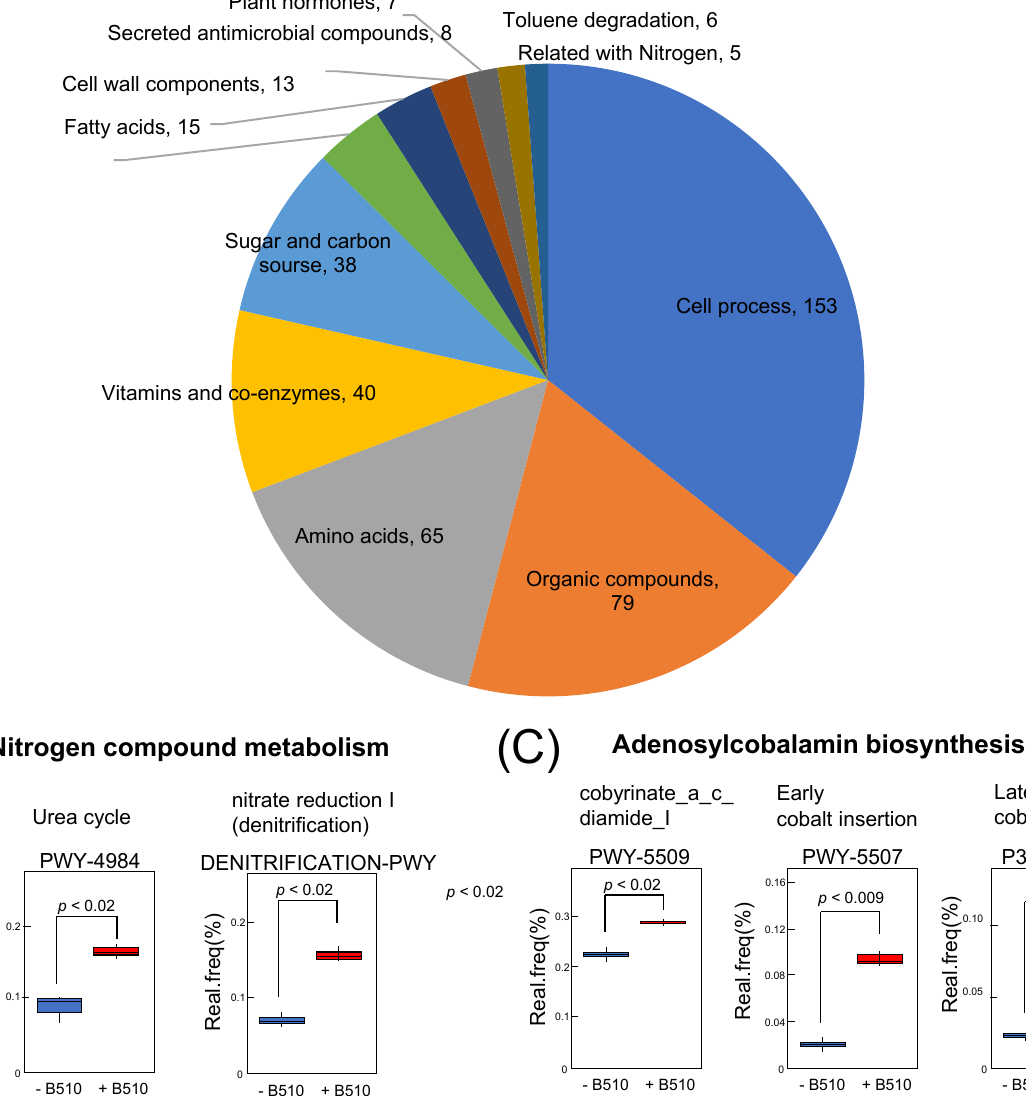
Figure 4. Functional composition profiles of bacterial communities. Bacterial communities were analyzed by PICRUSt2. Rice samples with significant differences ( p < 0.05) between those inoculated with and without B510 in the non-nitrogen fertilized condition. ( A ) Number of pathways selected in each category by PICRUSt2. ( B ) Real frequency (%) of nitrogen compound metabolism, and ( C ) real frequency (%) of cobalamin-related pathways as a function of B510